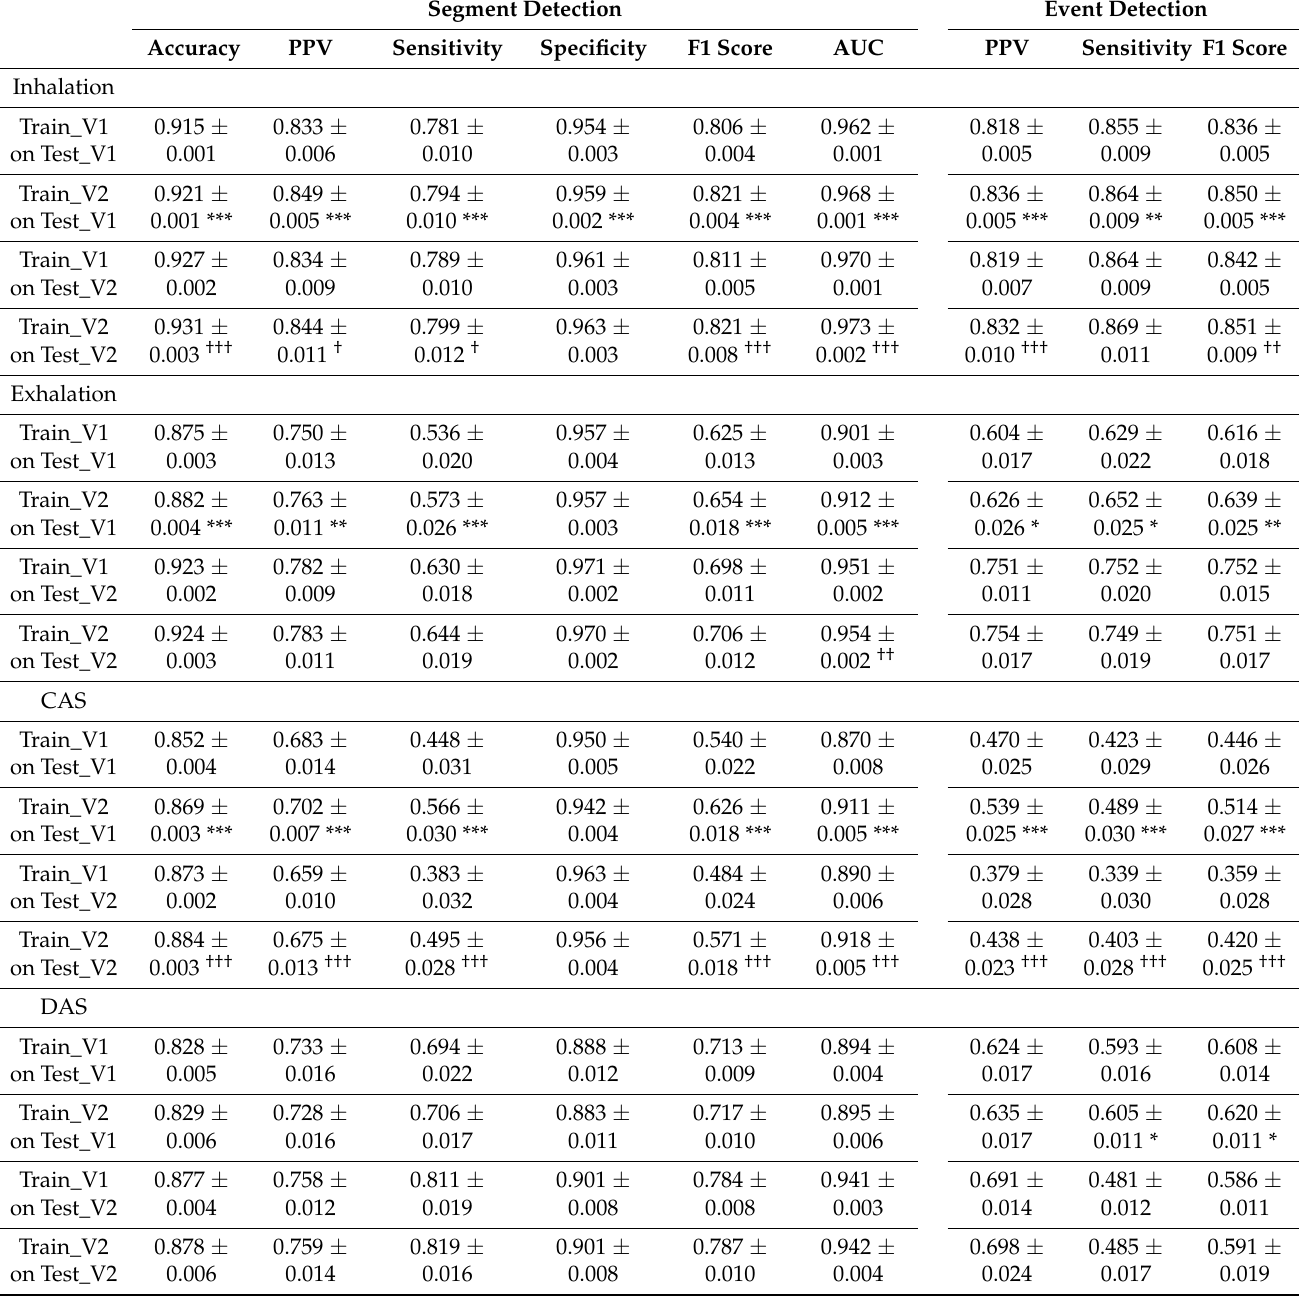
Table 4. Performance measurement of CNN-BiGRU models trained using V1_Train and V2_Train and tested on V1_Test and